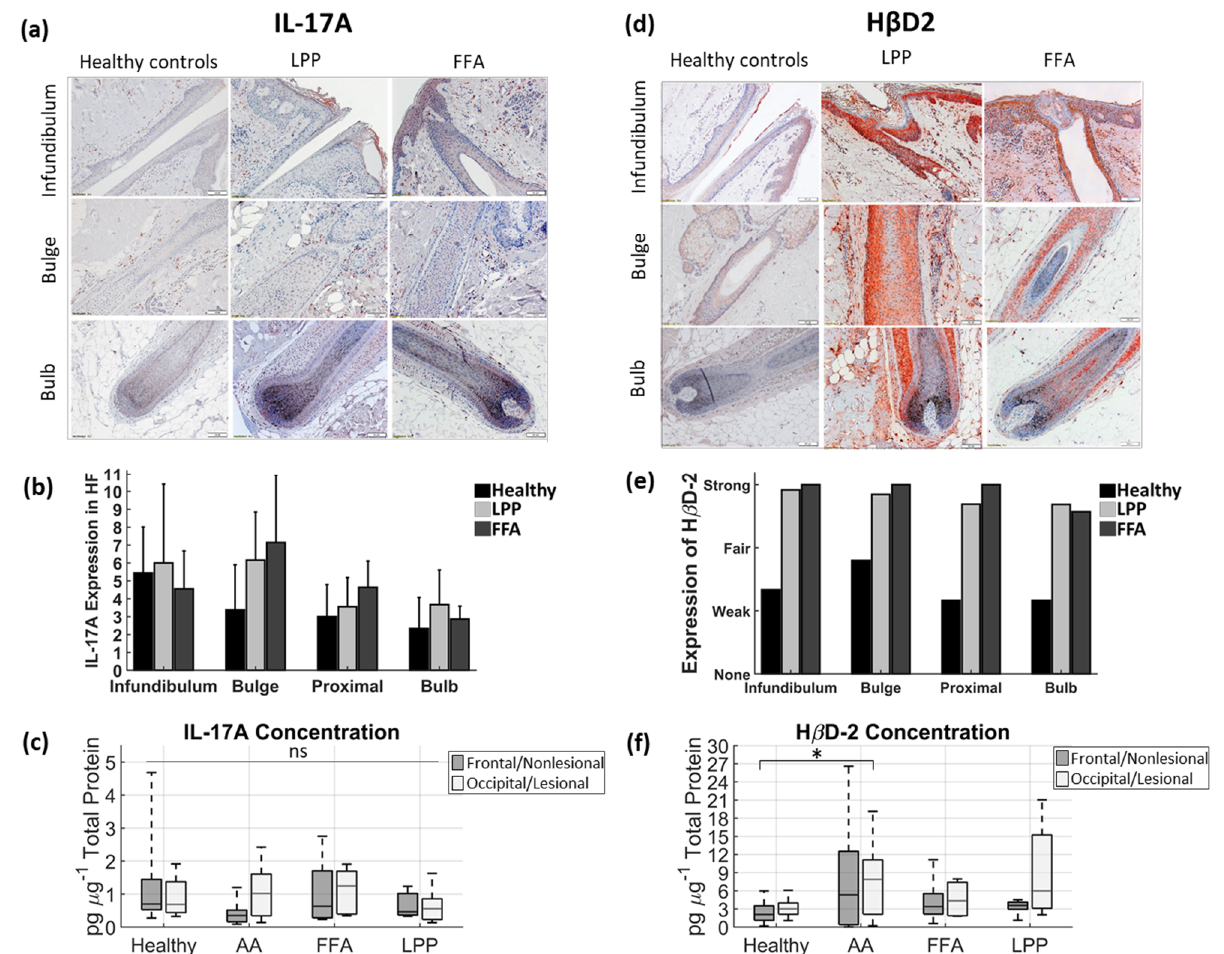
Figure 6. The expression of IL-17A and HβD2 in scalp lesions of patients with cicatricial alopecia and healthy subjects: ( a , b ) IL-17A; and ( d , e ) HβD-2 expression in paraffin-embedded sections of healthy scalp and cutaneous lesions (scalp) of cicatricial alopecia patients assessed by immunohistochemistry, followed by a semi-quantitative analysis. The figure panel pair images taken at different hair follicle depths of interest: infundibulum, central part (including bulge region) and bulb. Magnification × 100, scale bars = 100 µm. For ( b ) IL-17A, the y -axis shows the mean number of positive cells per follicular compartment. Marked presence of ( c ) IL-17A and ( f ) HβD2 in infra-infundibular compartments was further confirmed by ELISA analyses of plucked hair follicles from frontal and occipital scalps in healthy and lesional and non-lesional scalp areas in patients with AA ( n = 7), LPP ( n = 6) and FFA ( n = 6). In each box of the box plot, the central line indicates the median, and the bottom and top edges of the box indicate the 25th and 75th percentiles, respectively. The whiskers extend to the maximum and minimum data values. LPP; lichen planopilaris, AA; alopecia areata circumscripta, FFA; frontal fibrosing alopecia; ns, not significant; * p < 0.05 AA (lesional site) compared to healthy controls (frontal site).